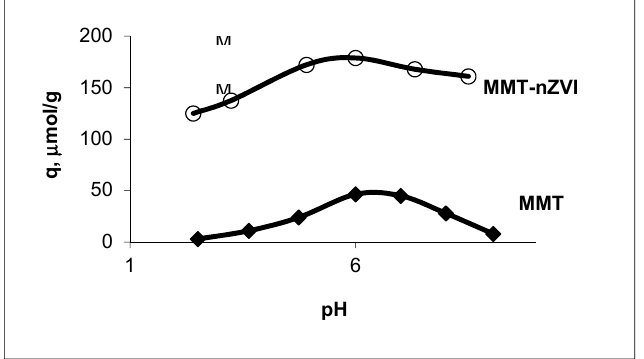
Figure 5. Sorption isotherms of U(VI) ions on pristine montmorillonite and montmorillonite-nZVI.